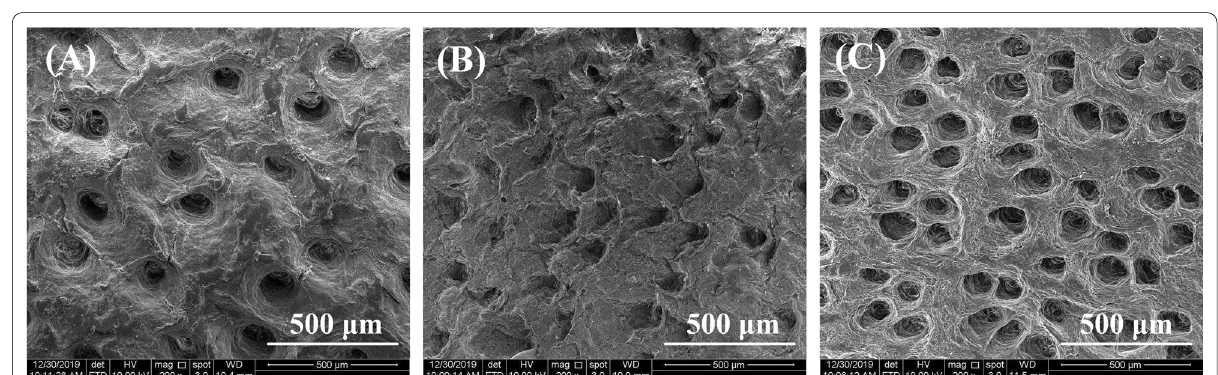
Fig. 5 SEM images of the grain tanned leather surface: A conventional process; B KCl-dispase process; C [AMIm]Cl-dispase process